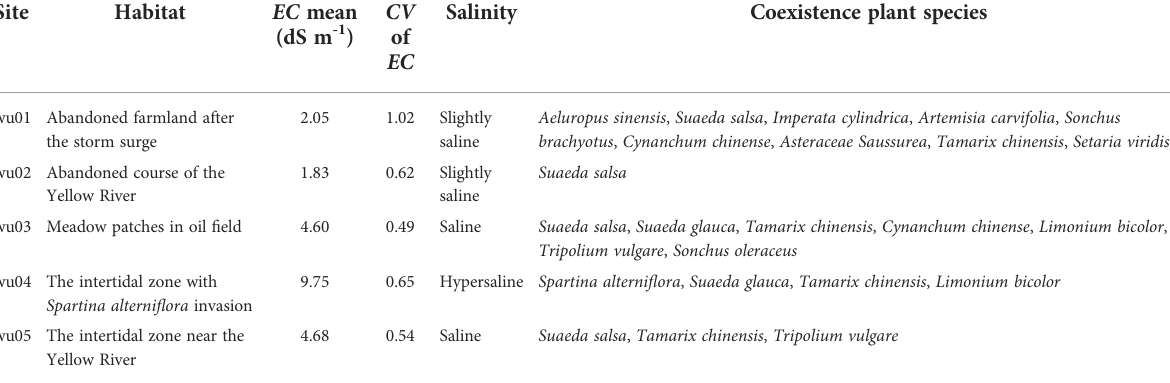
TABLE 1 The habitat information of sampled Phragmites australis populations in the Yellow River